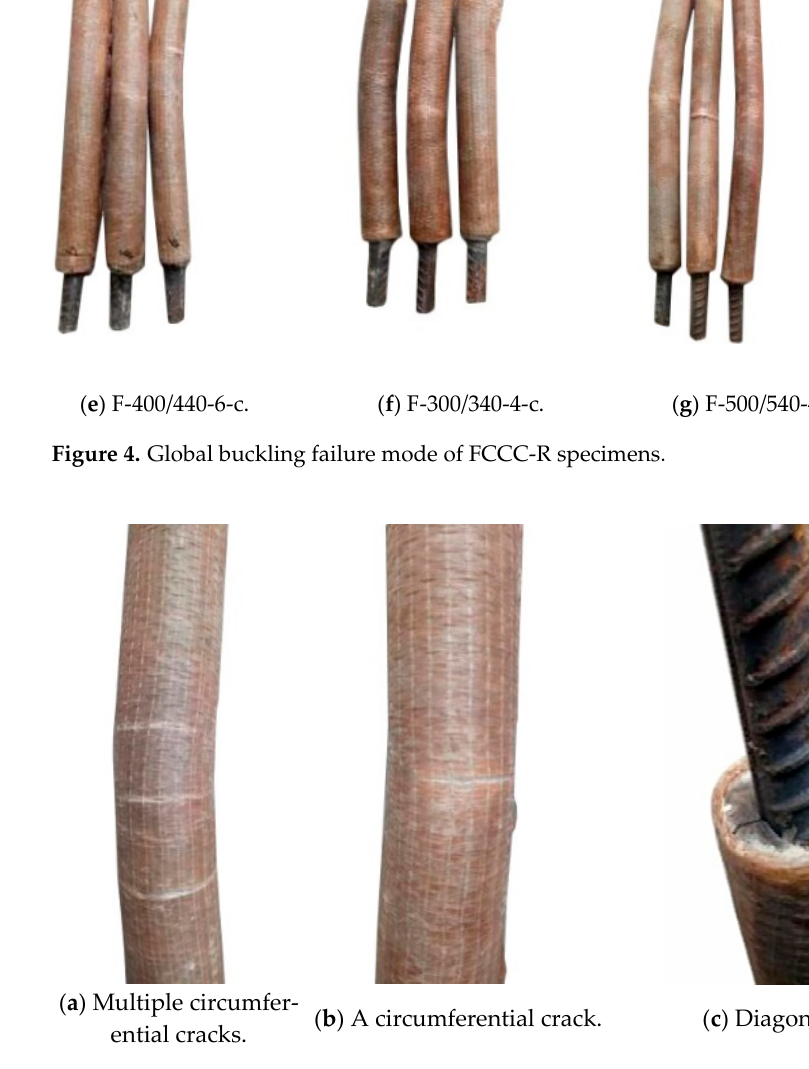
Figure 5. Local failure diagrams for FCCC-R specimens.